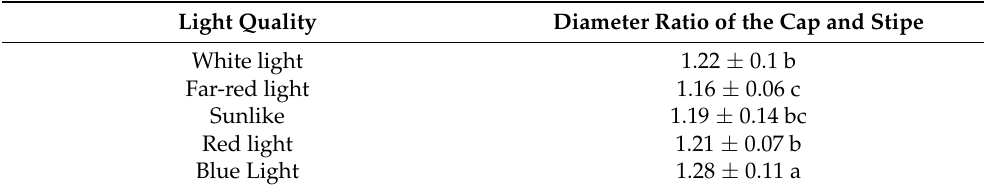
Table 4. Effect of different light quality treatments on the diameter ratio of the cap and stipe diameter ratio of the P. eryngii fruiting bodies. Light Quality Diameter Ratio of the Cap and Stipe White light Far-red light